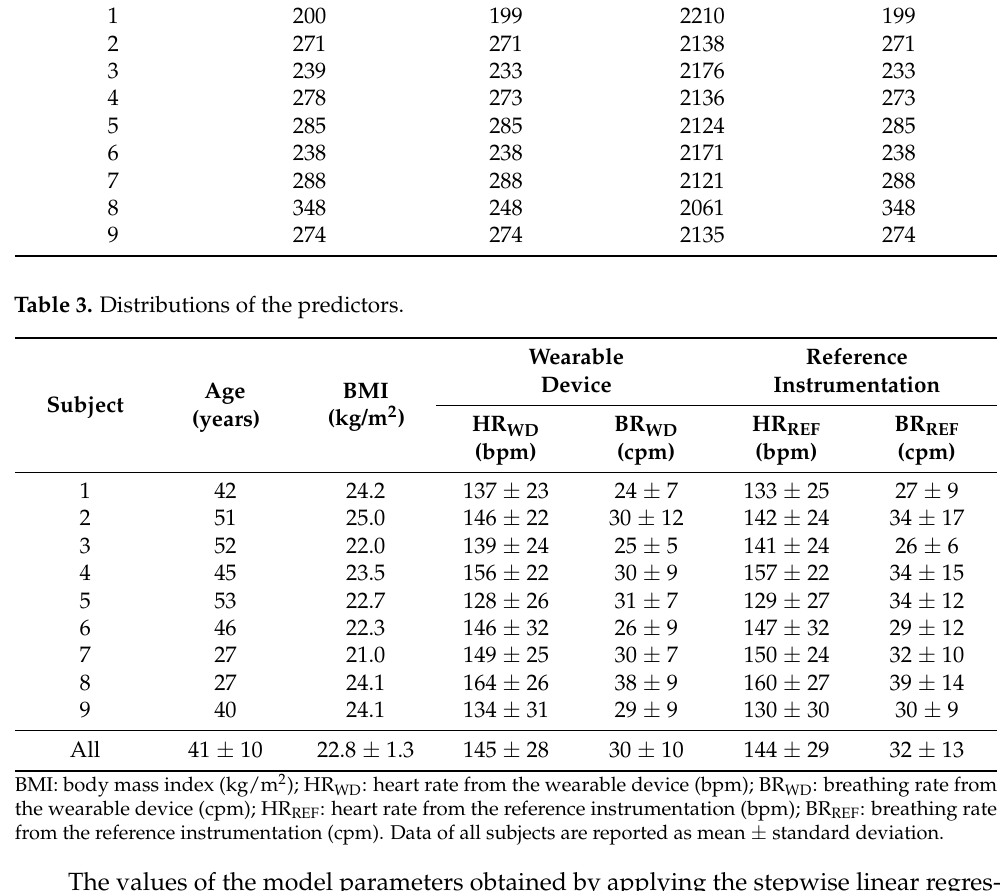
(cid:92) TV WD estimations